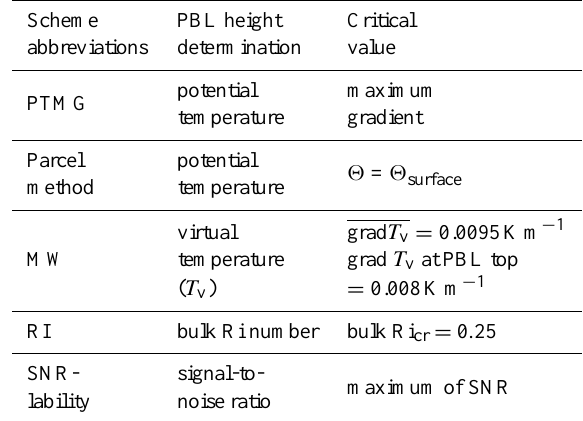
Table 2. Basic characteristics of the PBL height estimations applied to the measurements (PTMG – maximum gradient of potential tem- perature, MW – Matyasovszky and Weidinger (1998), RI – critical bulk Richardson number, SNR – maximum of signal-to-noise ratio).